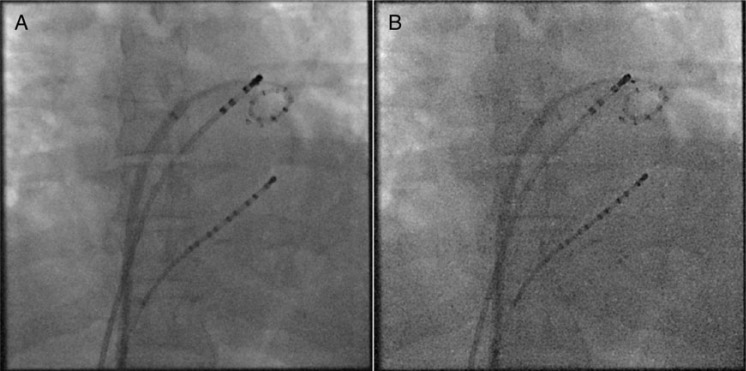
Anterior-posterior view fluoroscopic acquisitions using the old low-dose protocol (A) and the new lowest-dose protocol (B). The images show coronary sinus, circular mapping, and RF-ablation catheters.